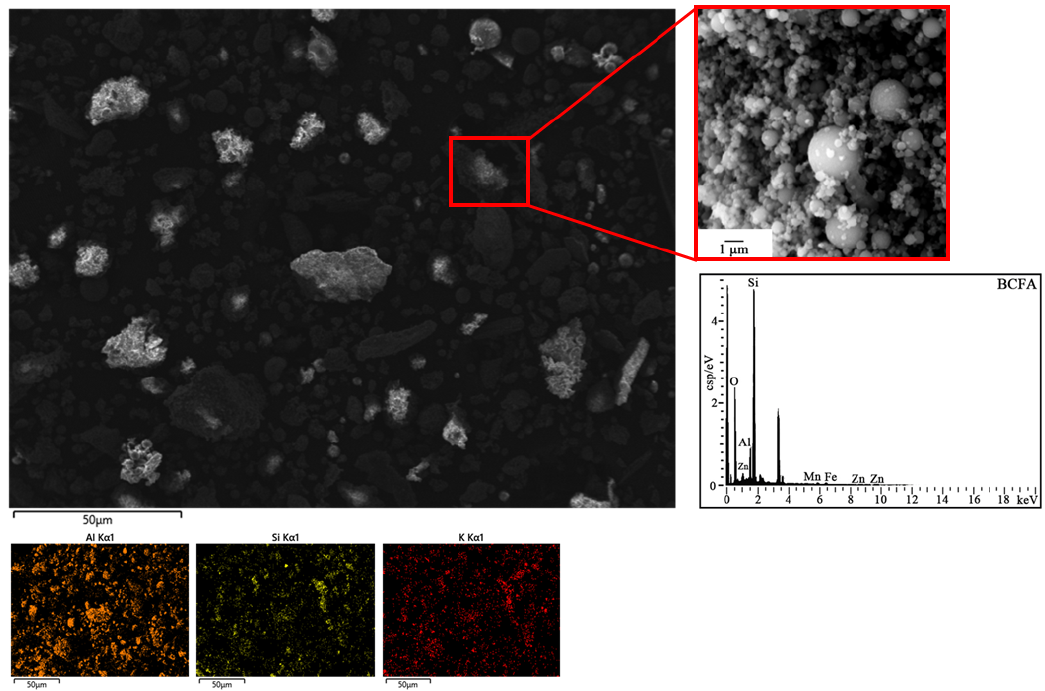
Figure 2. Energy-dispersive X-ray spectroscopy (EDS) profile of BCFA and the distribution of the elements Al, Si, and K.